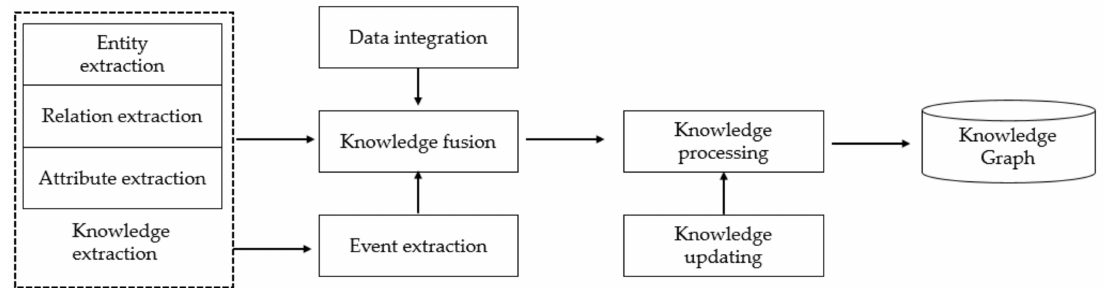
Figure 4. Knowledge map construction flow chart. After the entities, relations and attributes were extracted, knowledge fusion, processing and updating were carried out to generate the